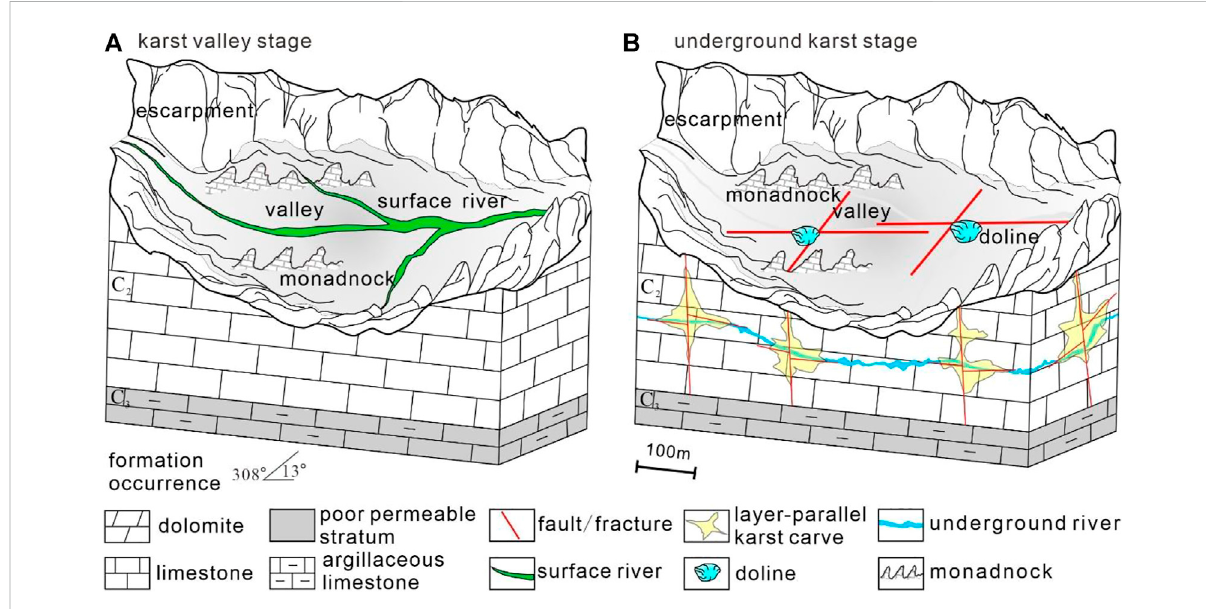
FIGURE 6 Developmentmodelofmodernkarstcontrolledbystrike-slipfaults; (A) karstvalleystage,anextensionaldepressionisdevelopedatthejunction of the two faults, and the river dissolves along the fracture; (B) underground karst stage, underground river is dissolved along the fault and karst depression is developed, typical geological phenomena such as monadnocks and dolines developed in karst